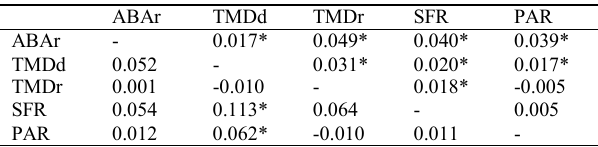
Table 7. Pairwise F (above diagonal) and pairwise R ST ST (bellow diagonal) values for Prochilodus costatus . * P < 0.05, after Bonferroni correction. ABAr = rio Abaeté at rainy season; PAR = rio Paracatu lagoons; SFR = rio São Francisco lagoons; TMDd = Três Marias Dam at dry season; TMDr = Três Marias Dam at rainy season.